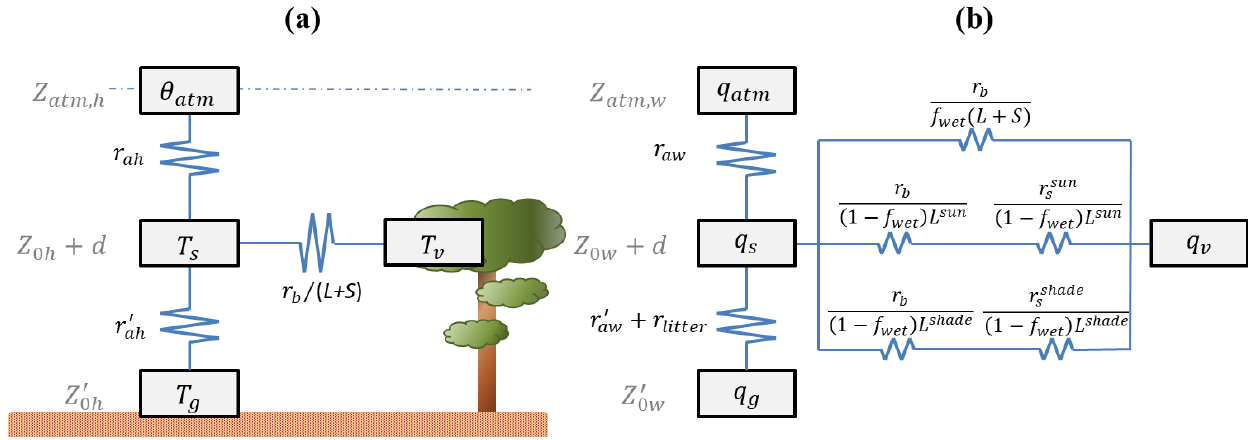
Figure 3. Resistance network schemes incorporated within CLM for (a) sensible heat flux and (b) latent heat flux. Main state variables are atmospheric potential temperature ( θ atm ) and specific humidity ( q atm ), canopy air temperature ( T s ) and specific humidity ( q s ), leaf temperature ( T v ) and its corresponding specific humidity ( q v ), and ground temperature ( T g ) and its corresponding specific humidity ( q g ). Relevant heights are the atmospheric reference height ( z atm ), the canopy roughness height ( Z 0 ), the groundwater roughness height ( Z (cid:48) and the displacement height ( d ). Resistances are specified by their scalar ( h for heat and w for water vapor), type ( a for aerodynamic, b for boundary layer, s for stomatal, or litter for litter), and lighting ( sun or shade ). Leaf wetness also exerts a control on fluxes via a wetness fraction ( f wet ), and ( L + S ) is the leaf and stem area index. Figure adapted after Oleson et al.